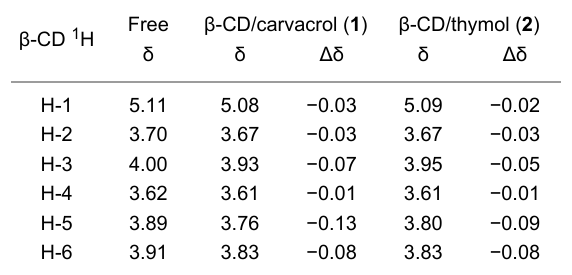
Table 2: 1 H Chemical shifts ( δ , ppm) corresponding to β -CD protons in the free and complexed states in the presence of equimolar amounts of either carvacrol ( 1 ) or thymol ( 2)